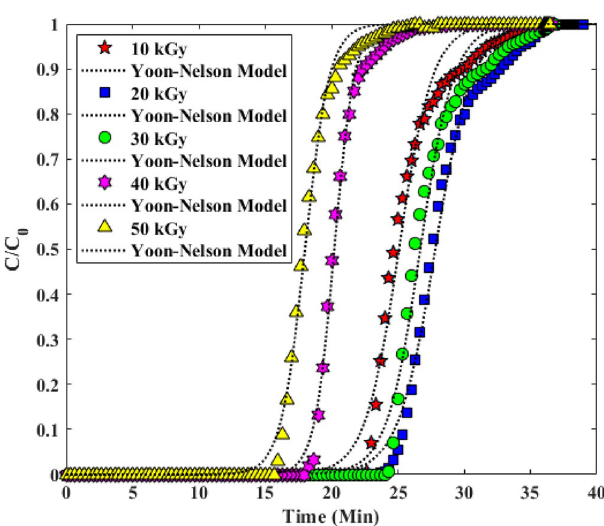
Figure 12. Investigation of Experimental Breakthrough curves in columns with Yan-Nelson